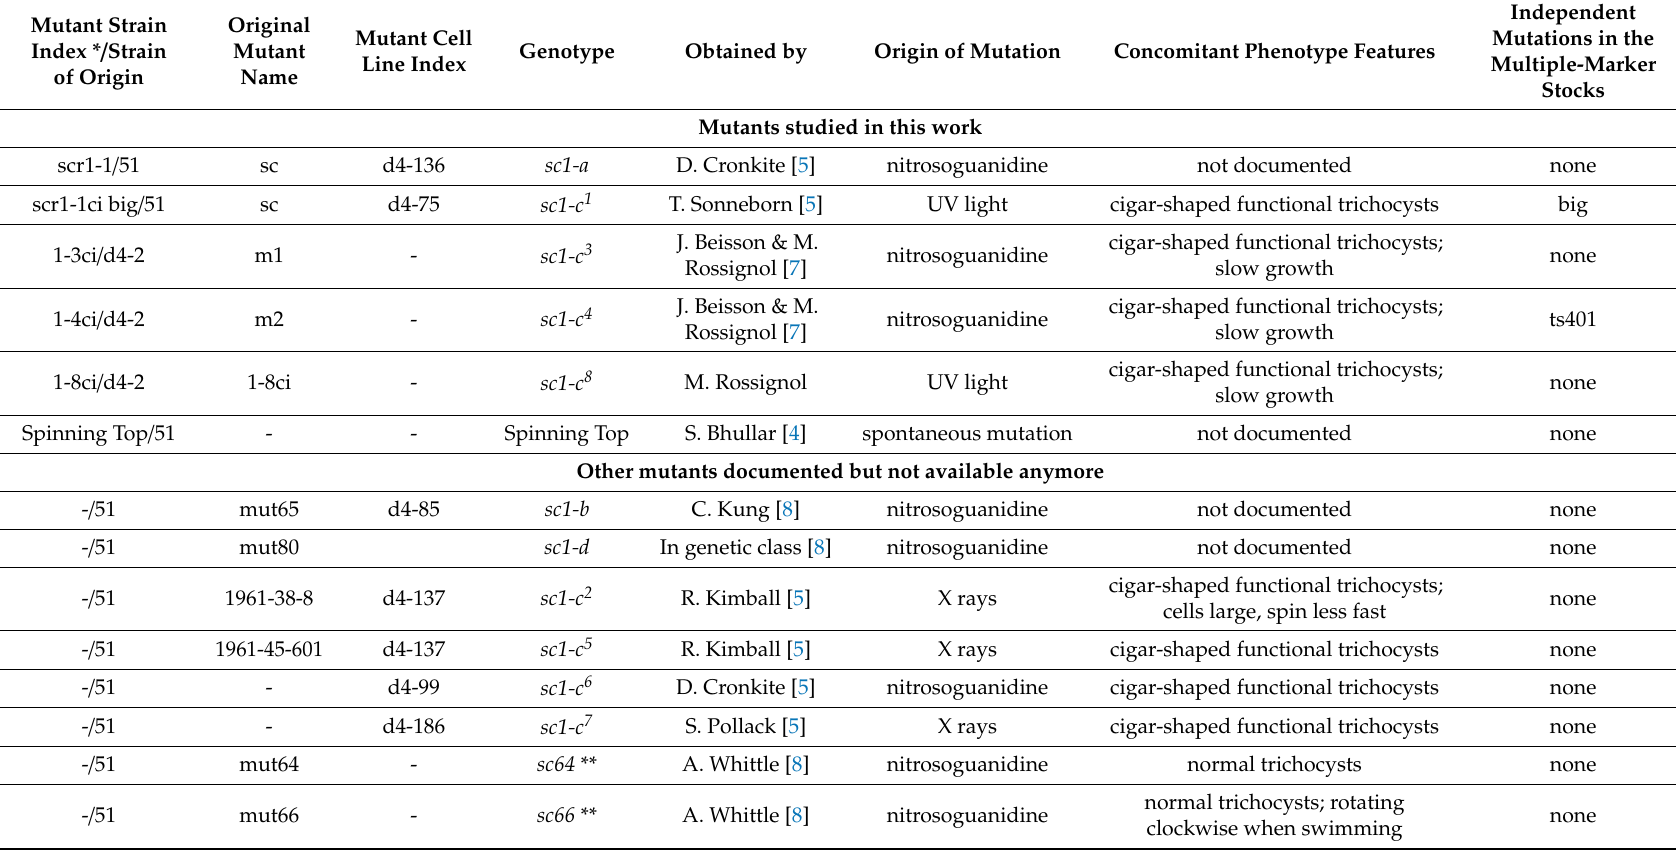
Table 1. P. tetraurelia mutants with screwy